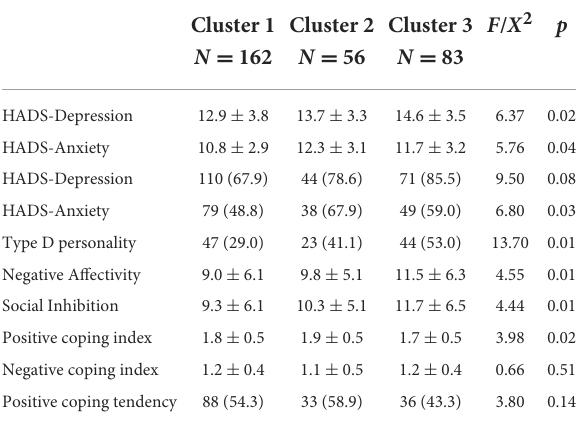
TABLE 6 Psychological, personality, and familiar coping characteristics at baseline among three clusters.